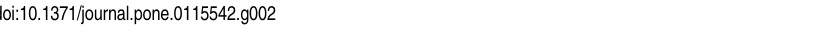
PLOS ONE | DOI:10.1371/journal.pone.0115542 December 26,